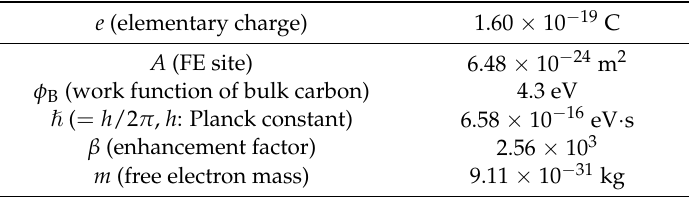
Table 1. Parameters used in the theoretical calculations. A and β were obtained by simulation using the method in Ref.